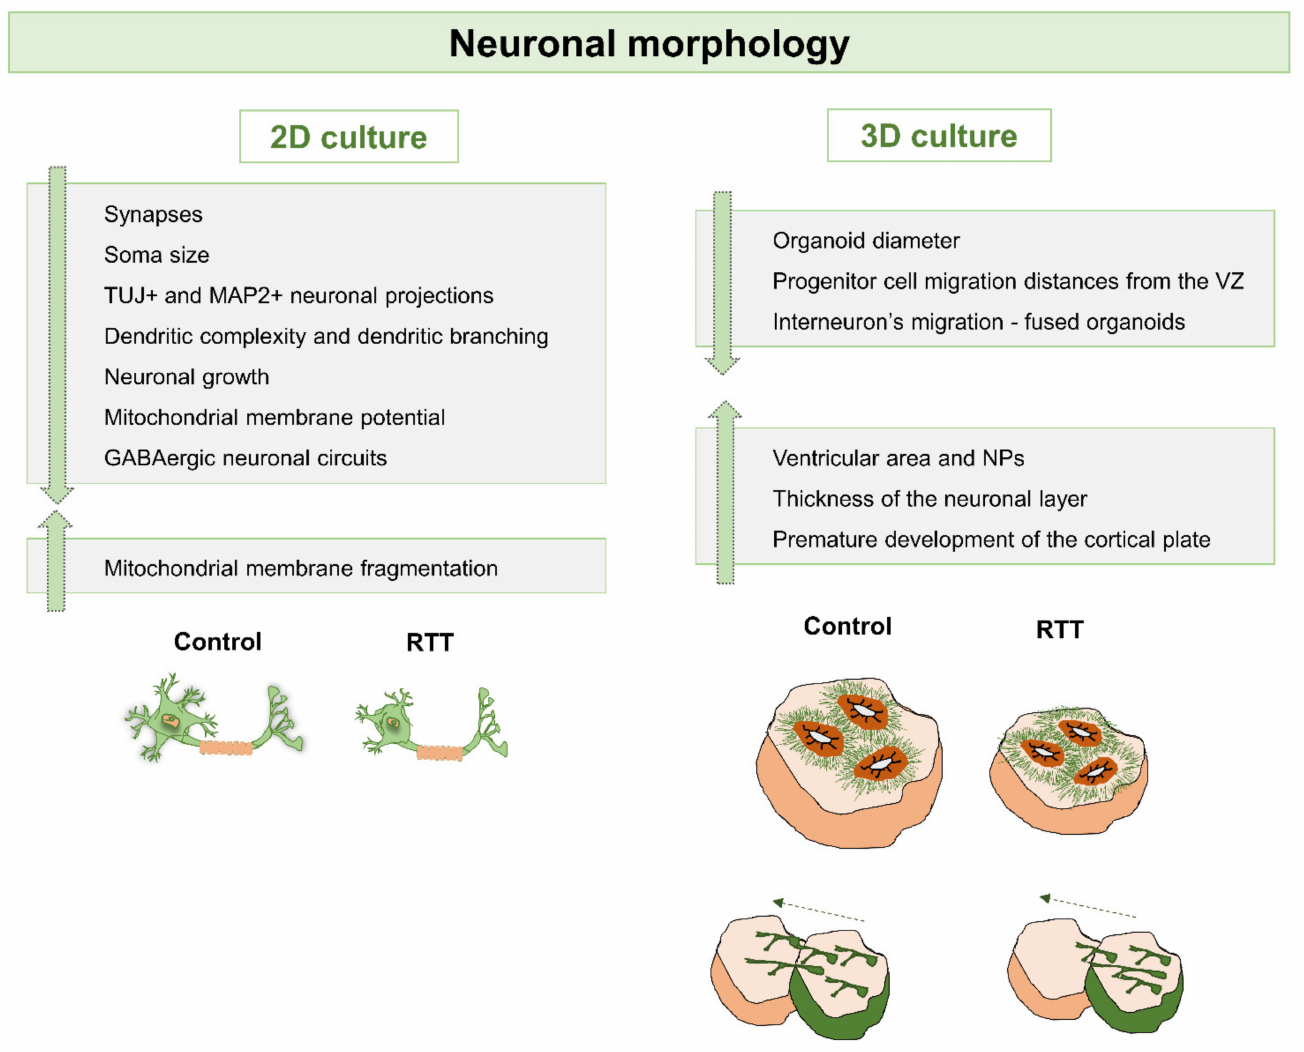
Figure 2. Schematic view of neuronal morphology-related alterations observed in 2D and 3D models of RTT derived from hiPSCs. Neuronal structures, such as synapses, dendrites, neuronal projections, mitochondria, and some cortical layers have been observed to be altered in RTT. Highlighted in this figure are the alterations in the cell migration process and organoid size, as well as smaller cell soma size, altered dendrites and smaller neuronal projections of neuronal